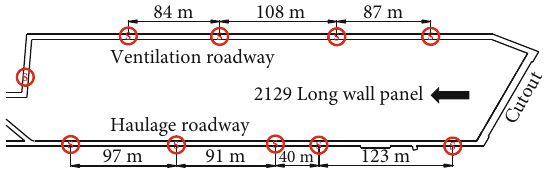
Figure 11: Layout of microseismic monitoring